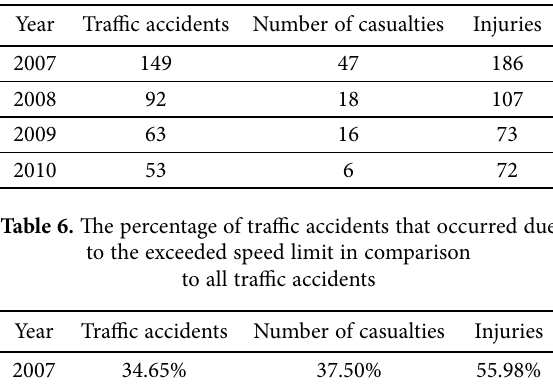
Table 5. Statistics revealing the percentage of traffic